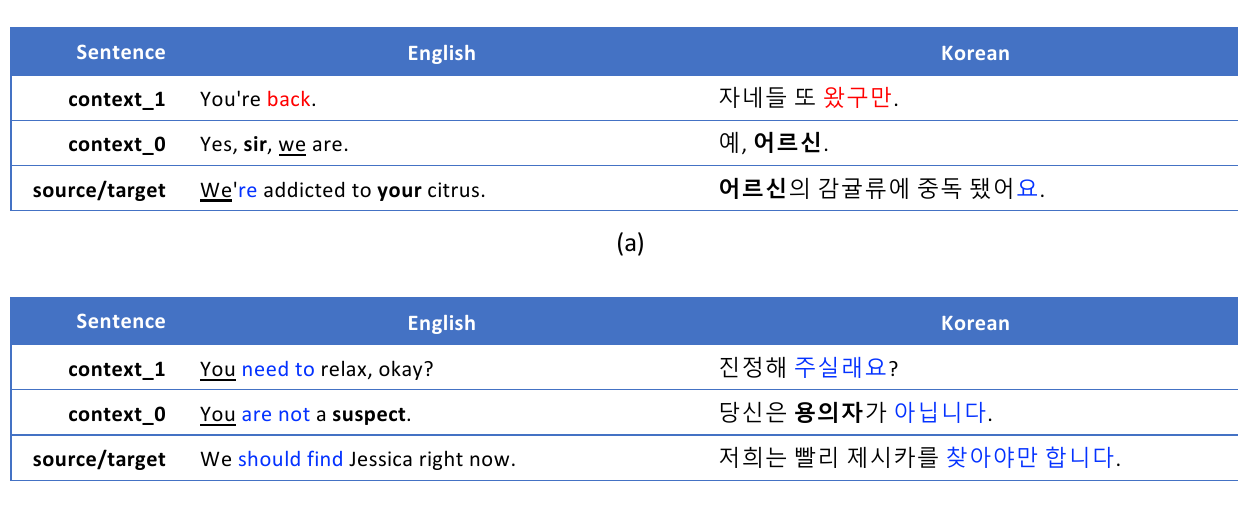
Figure 2. Two examples of Korean dialogue from our dataset, which are extracted from subtitles. The blue words are verbs that translated with polite and/or formal honorifics whereas the red words are translated with impolite and/or informal honorifics. The bold keywords are used to determine what types of honorifics should be used. The underlined pronouns indicate that the two utterances is told by the same speaker in ( a ) and the utterances are formal speech in ( b